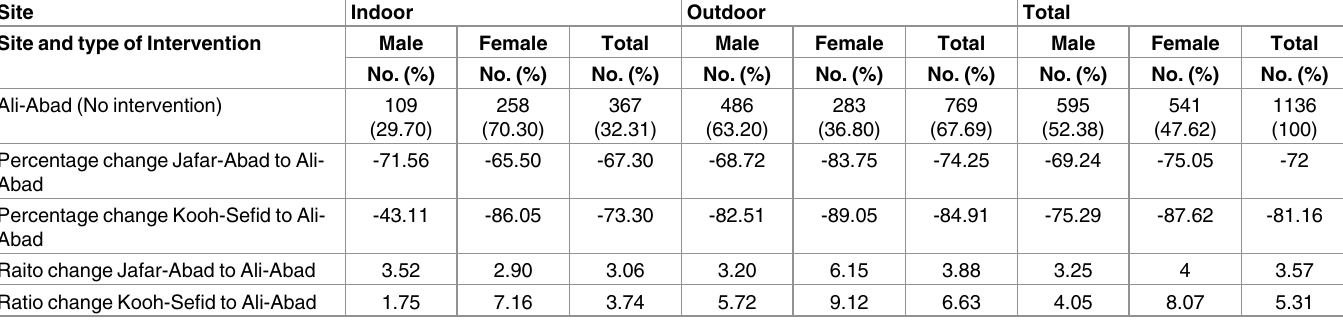
Table 8. The comparison of P . papatasi frequency indoors and outdoors in Jafar-Abad(plants, bushes, and shrubs sprayed with ATSB) and Kooh-Sefid (ATBS-treated barrier fences) with Ali-Abad (no intervention) using sticky traps, Markazi District, Qom province, 2015. Site Indoor